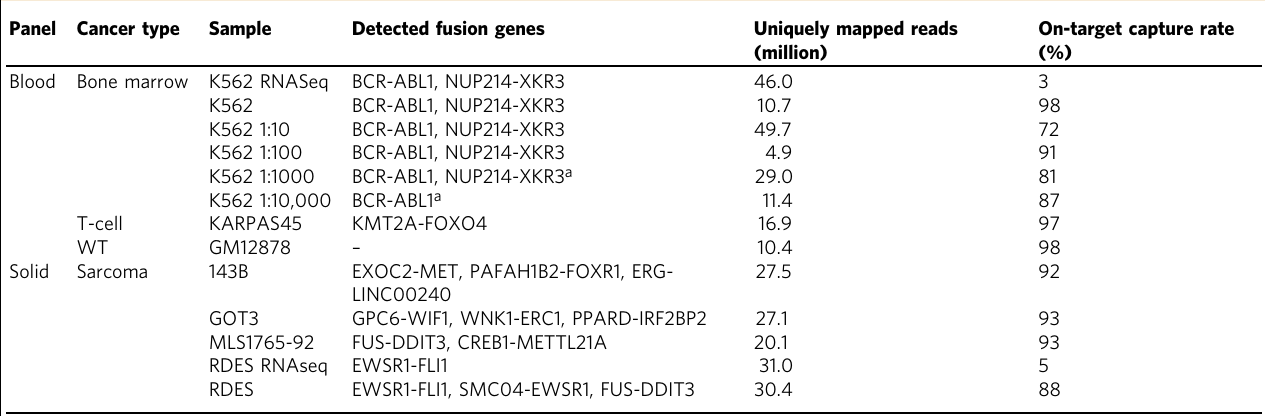
Table 1 Summary of cell line fusion genes and mapping statistics Panel Cancer type